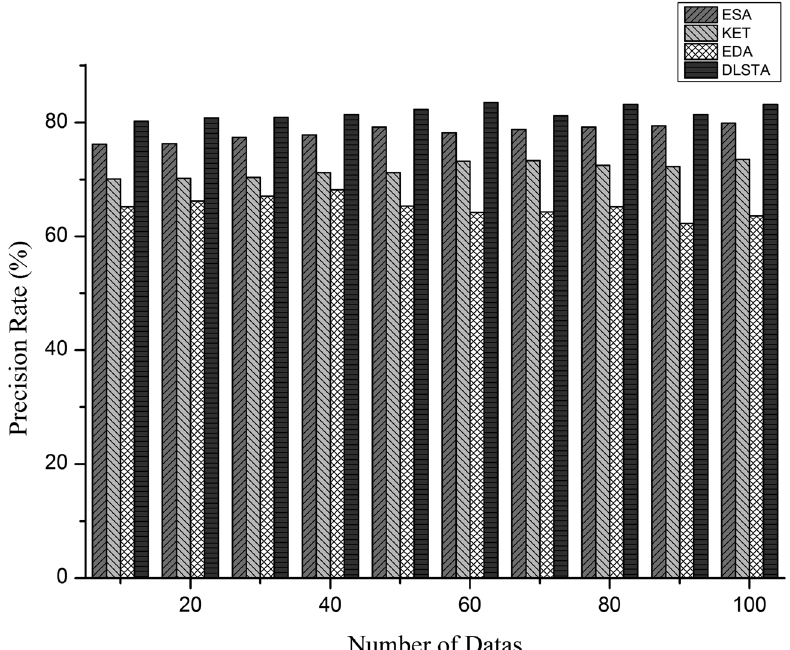
Figure 7: The precision rate of DLSTA.